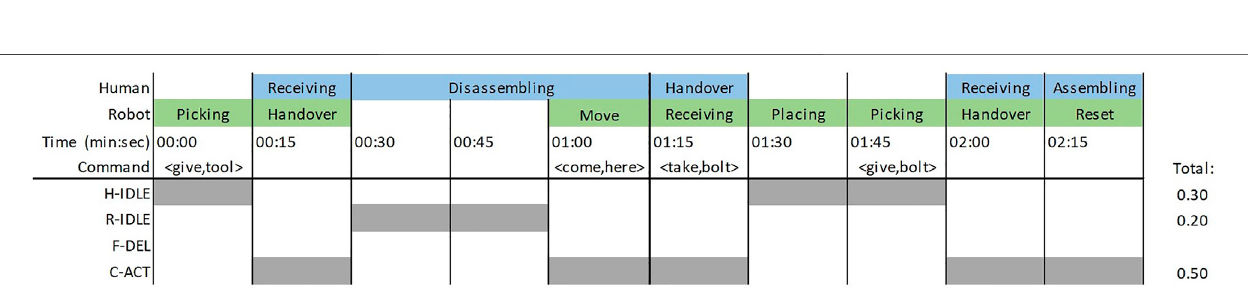
commands requested by the human and utilized for robot coordination are depicted as well, and demonstrate the variation in robot actions and how they can be requested. In this case, commands are identical to the graphical command-